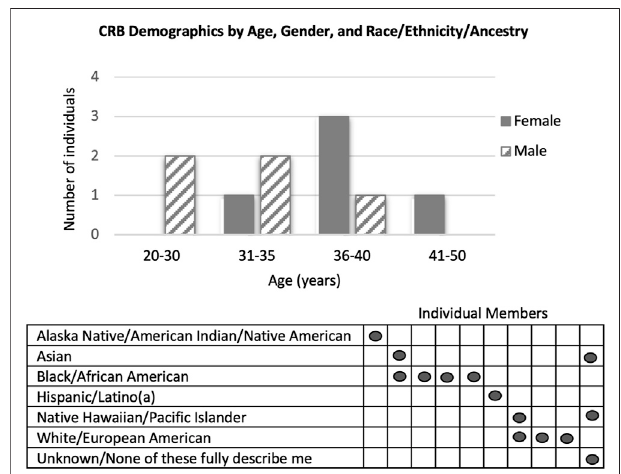
FIGURE 1 | Demographics of CRB members by Age, Gender, and Race/Ethnicity/Ancestry. In the Race/Ethnicity/Ancestry table, each vertical column represents an individual member of the